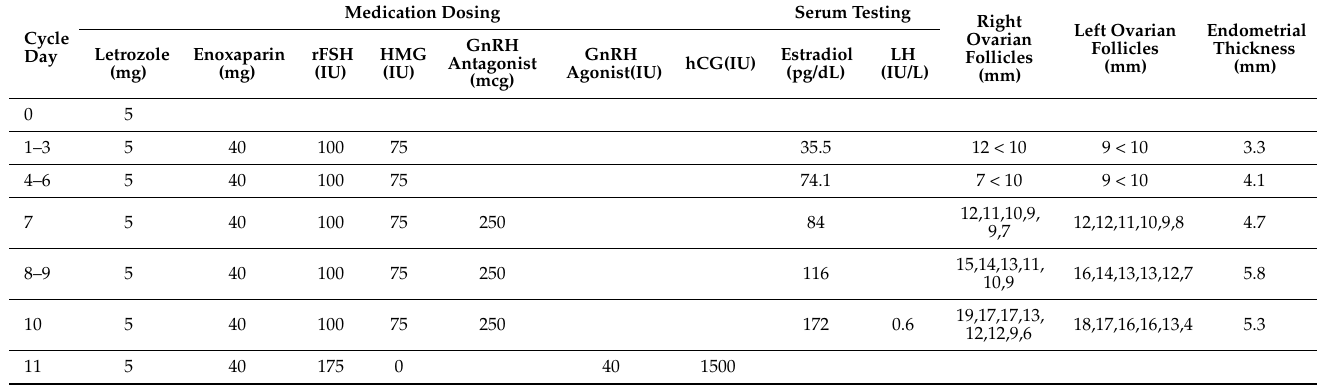
Table 1. Stimulation Summary.